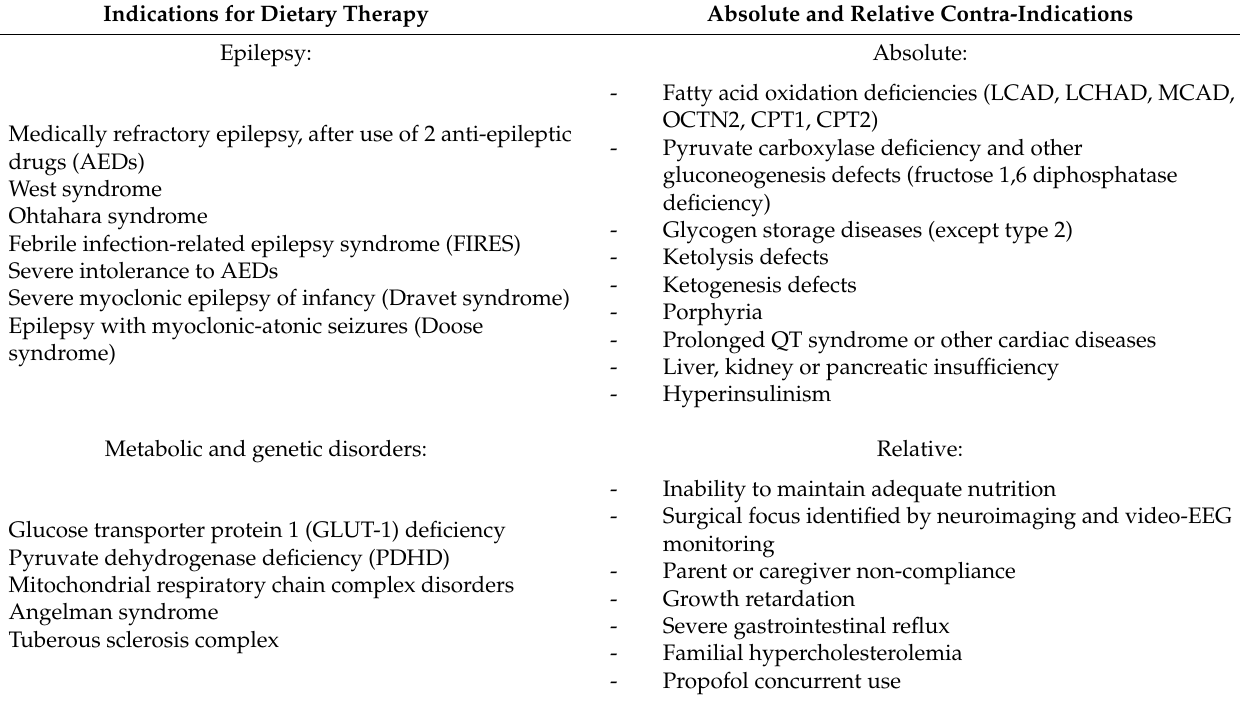
Table 2. Indications and contra-indications of ketogenic diet in